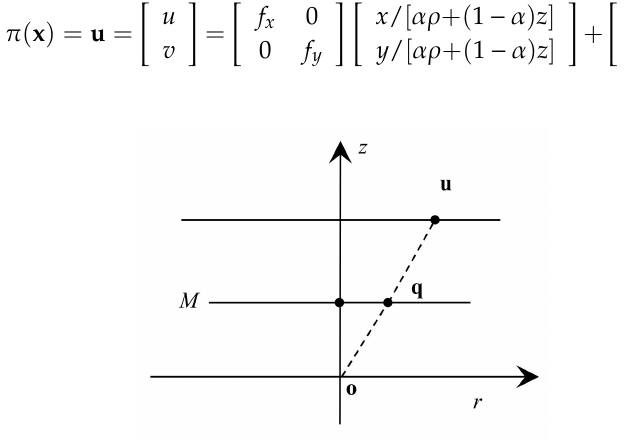
Figure 3. The pinhole camera